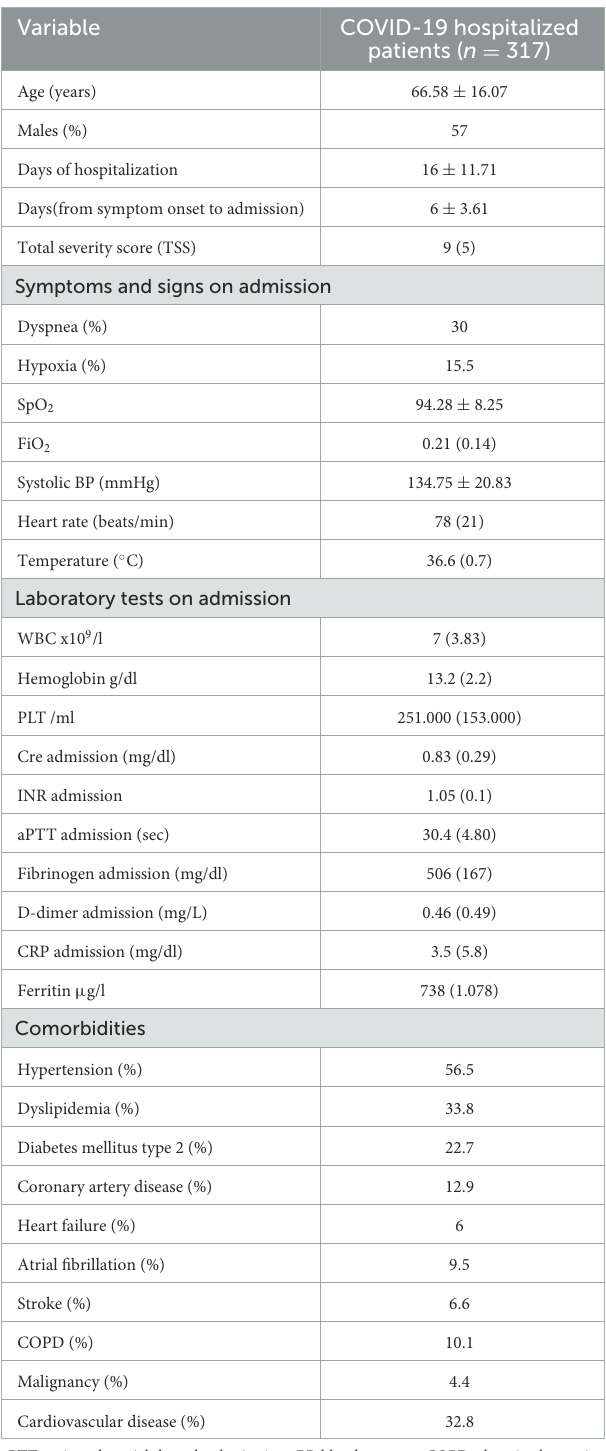
TABLE 1 Characteristics of the study